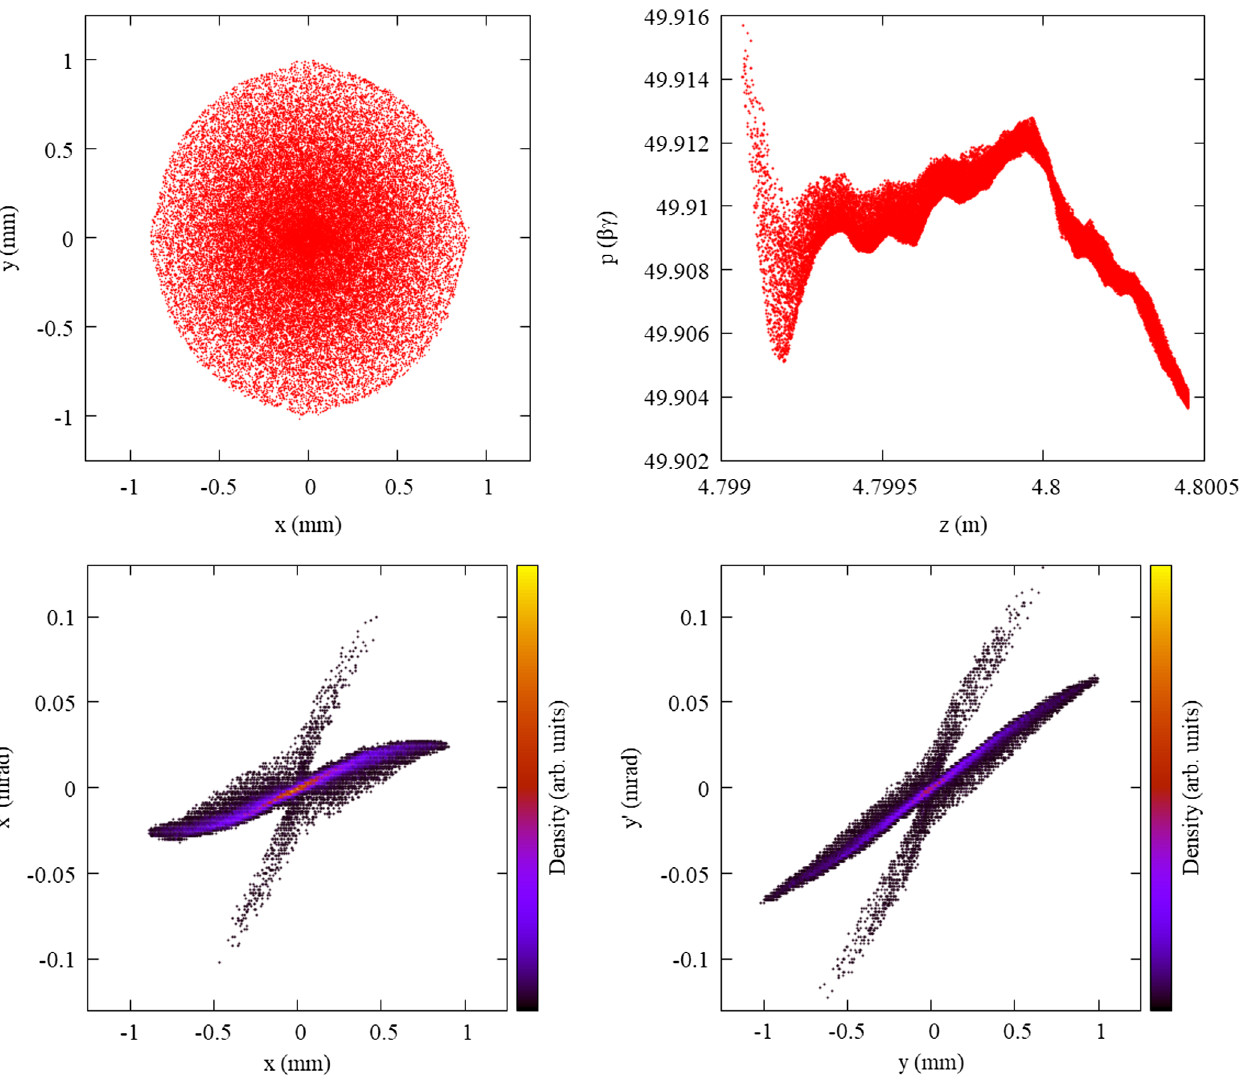
FIG. 7. Beam spot (upper left), longitudinal phase space (upper right), horizontal phase space (bottom left), and vertical phase space (bottom right) of bunch after exiting the